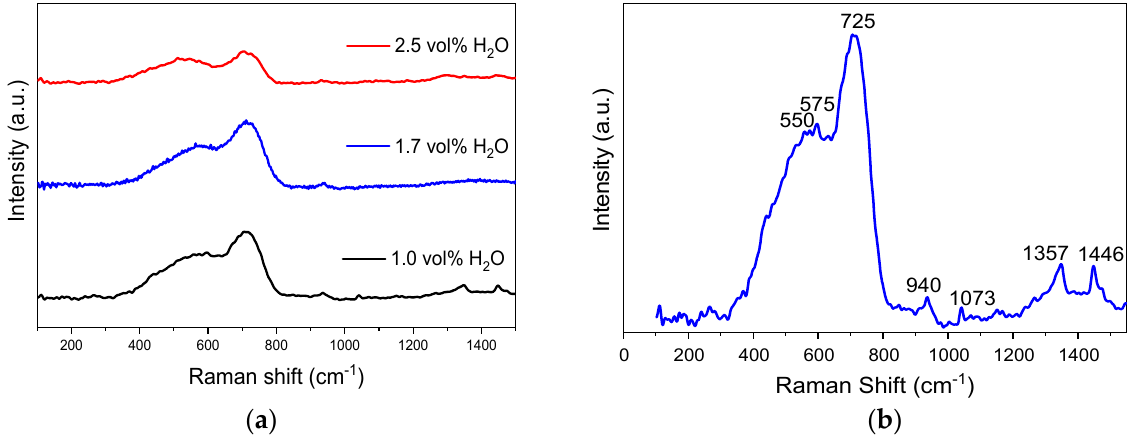
Figure 9. Raman spectra of the anodic layers grown in glycerol, 0.05 M Na 2 SiO 3 with H 2 O concentrations ( a ) from 1.0 to 2.5 vol%, and ( b ) 1.7 vol% for 6 min at 20 mA/cm 2 .